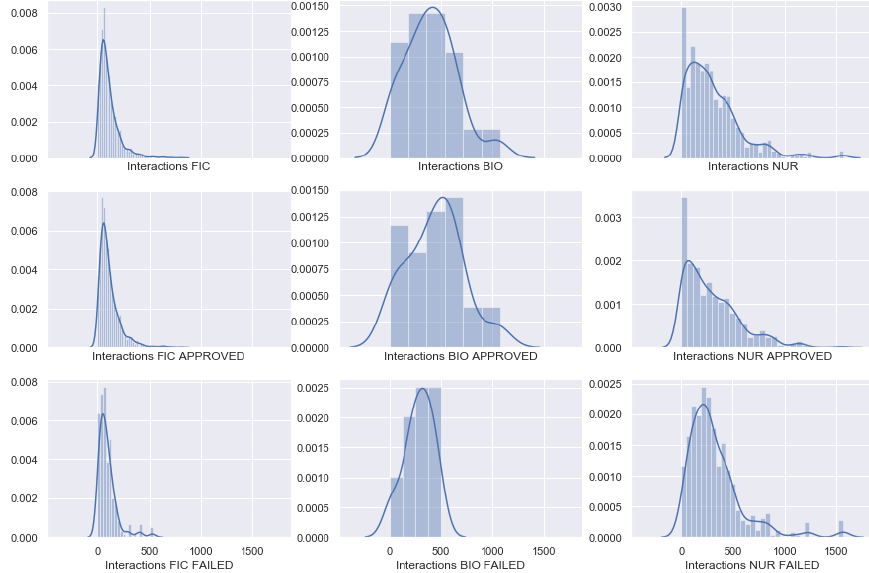
Figure 7. Distribution of interactions by courses. Table 3. Statistical